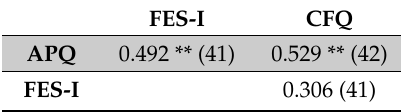
Table 2. Bivariate correlations (N) between APQ, FES-I and